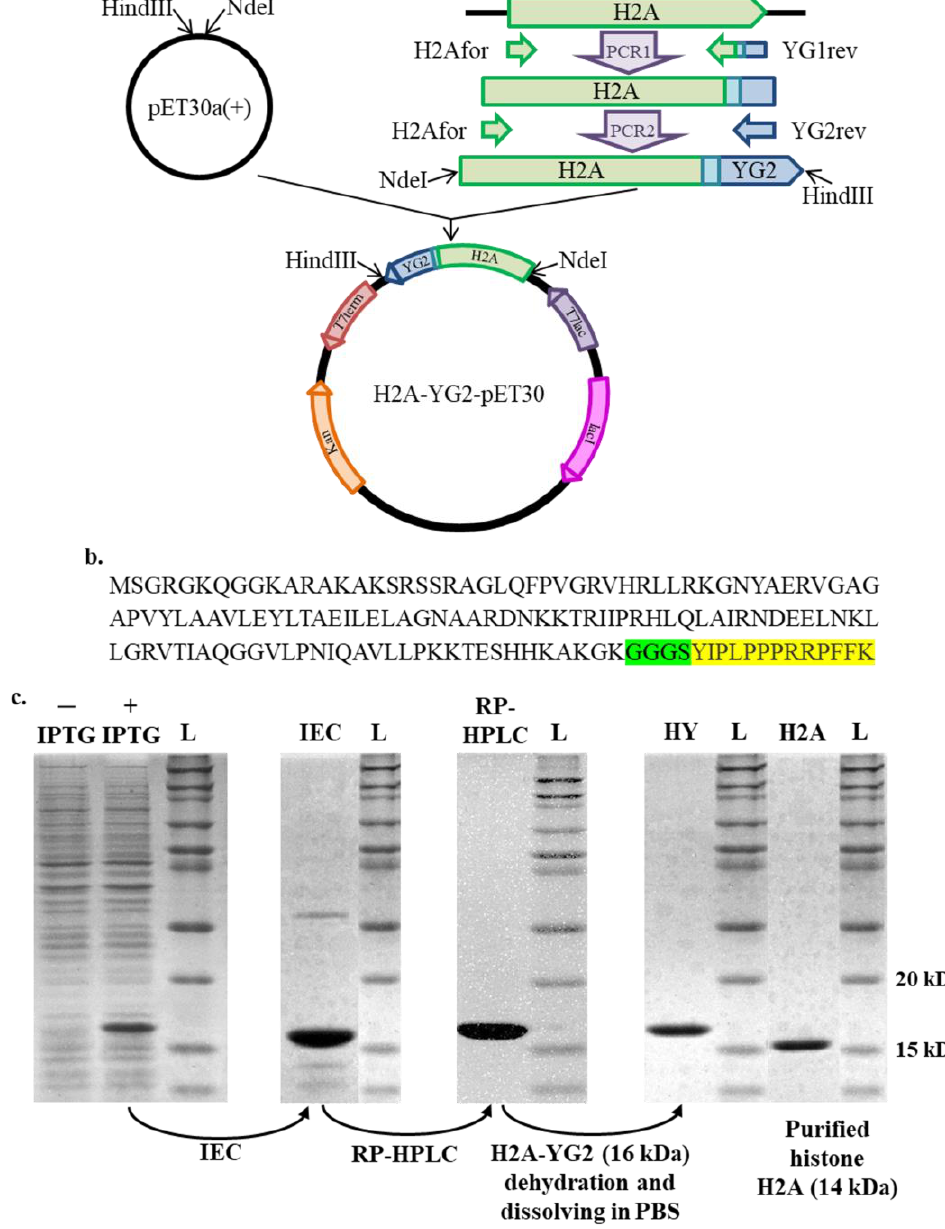
Figure 1. Cloning and production of recombinant histone H2A fused to YG2. ( a )—H2A-YG2 cloning strategy, ( b )—An amino acid sequence of H2A-YG2, histone H2A sequence is not highlighted, the linker sequence is highlighted in green, and the YG2 sequence is highlighted in yellow. ( c )—Purification of H2A-YG2 from the clarified lysate. Lysates of E. coli cells without (-IPTG) and with ( + IPTG) addition of IPTG, H2A-YG2 containing fractions from ion-exchange chromatography (IEC), reverse-phase HPLC (RP-HPLC), and final protein preparation (HY, 16 kDa) are shown. Purified histone H2A (H2A, 14 kDa) is also shown. The Novex Sharp Pre-Stained Protein Standard (L) is shown as a